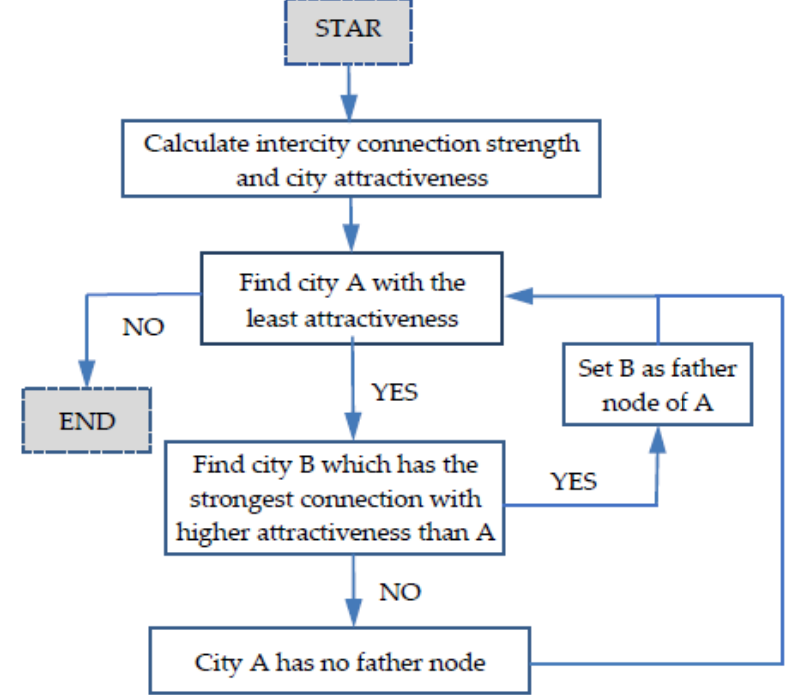
Figure 2. Flowchart of hierarchical analysis algorithm.